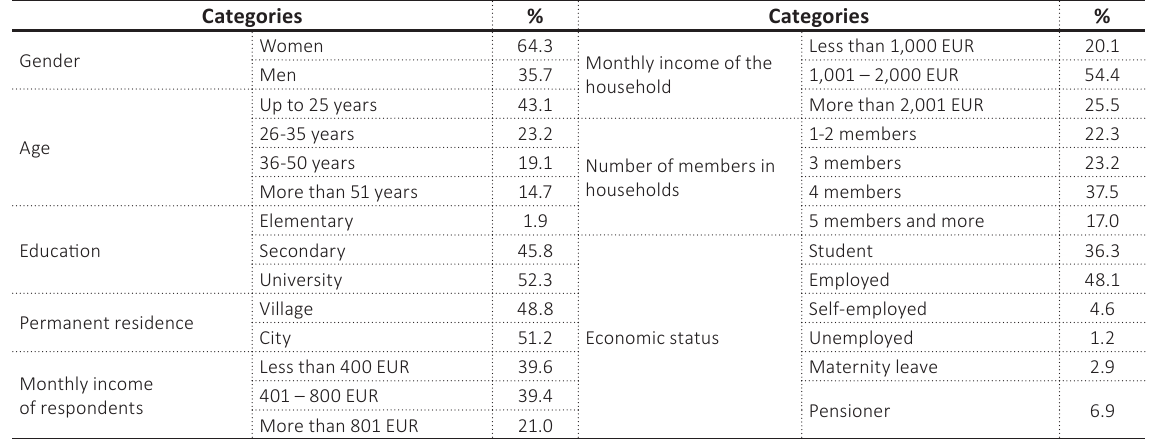
Table A2. Structure of respondents involved in the consumer survey